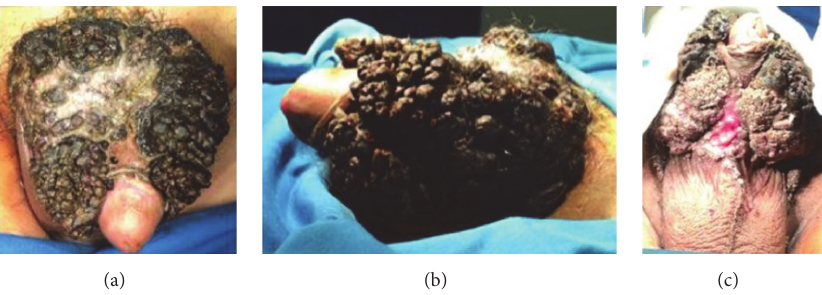
Figure 1: Condyloma acuminata’s clinical manifestation. (a) Dorsal; (b) lateral; (c) ventral.